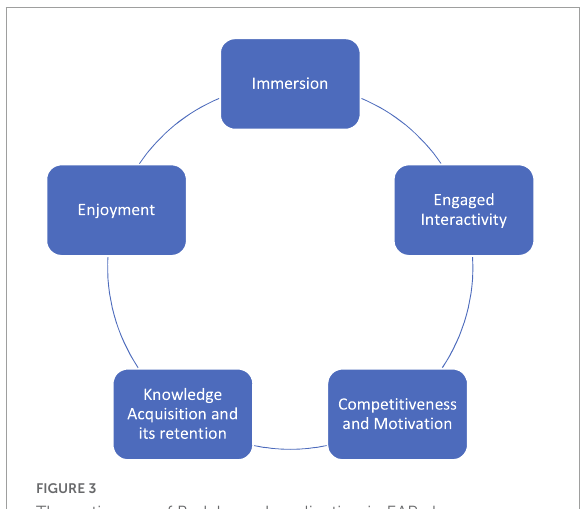
FIGURE3 Thematic map of Badaboom! application in EAP